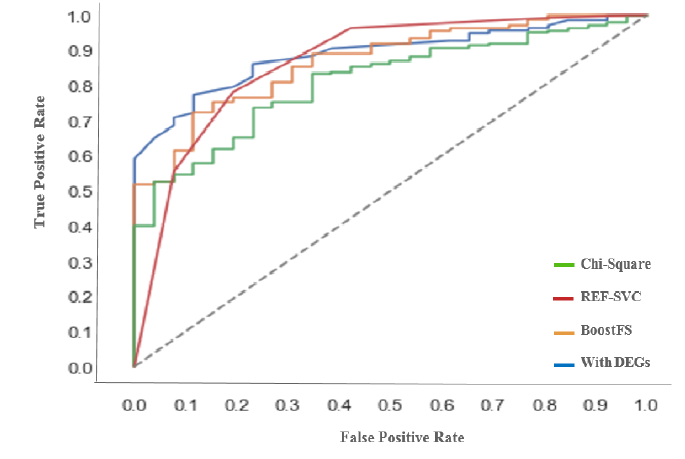
Figure 4. ROC curve for the proposed approach with different feature